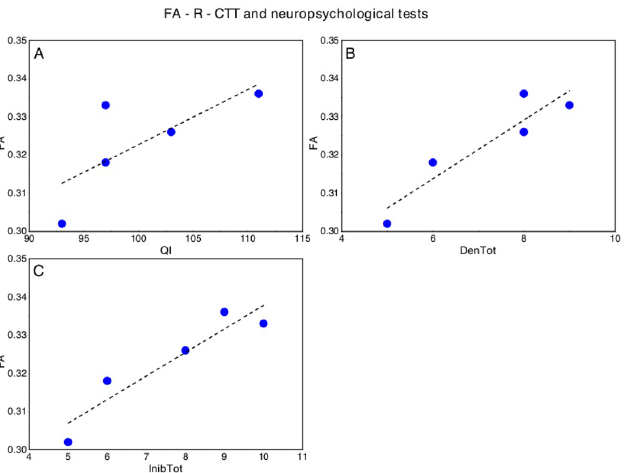
Fig 3. Significant correlations between FA-R-CTT and neuropsychological tests in DMD, in particular with respect to (A) Full Intellectual Quotient (FIQ, WISC-IV), (B) Denomination Total (DenTot, Inhibition test- NEPSY II) and (C) Inhibition Total (InhibTot, Inhibition test- NEPSY II). The dotted lines represent the linear fit of the data with a function y = a + b � x. A) FA-R-CCT versus FQI: a = 0.18 ± 0.08, b = 0.001 ± 0.0008, Pearson’s R = 0.74, Adj R2 = 0.40; B) FA-R-CCT versus: a = DenTot: 0.27 ± 0.01, b = 0.008 ± 0.0002, Pearson’s R = 0.93, Adj R2 = 0.81; C) FA-R-CCT versus InibTot: a = 0.28 ± 0.01, b = 0.006 ± 0.0001, Pearson’s R = 0.94, Adj R2 = 0.84.